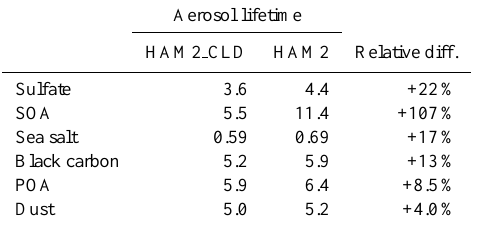
Table 7. Impact of cloud microphysics parameterization on aerosol lifetime (unit: day). The sensitivity experiment HAM2 CLD uses the scheme of Lohmann and Roeckner (1996), while the standard ECHAM-HAM2 model uses the two-moment scheme of Lohmann et al. (2007). Further details can be found in Sect. 4.1.6. Aerosol lifetime Relative